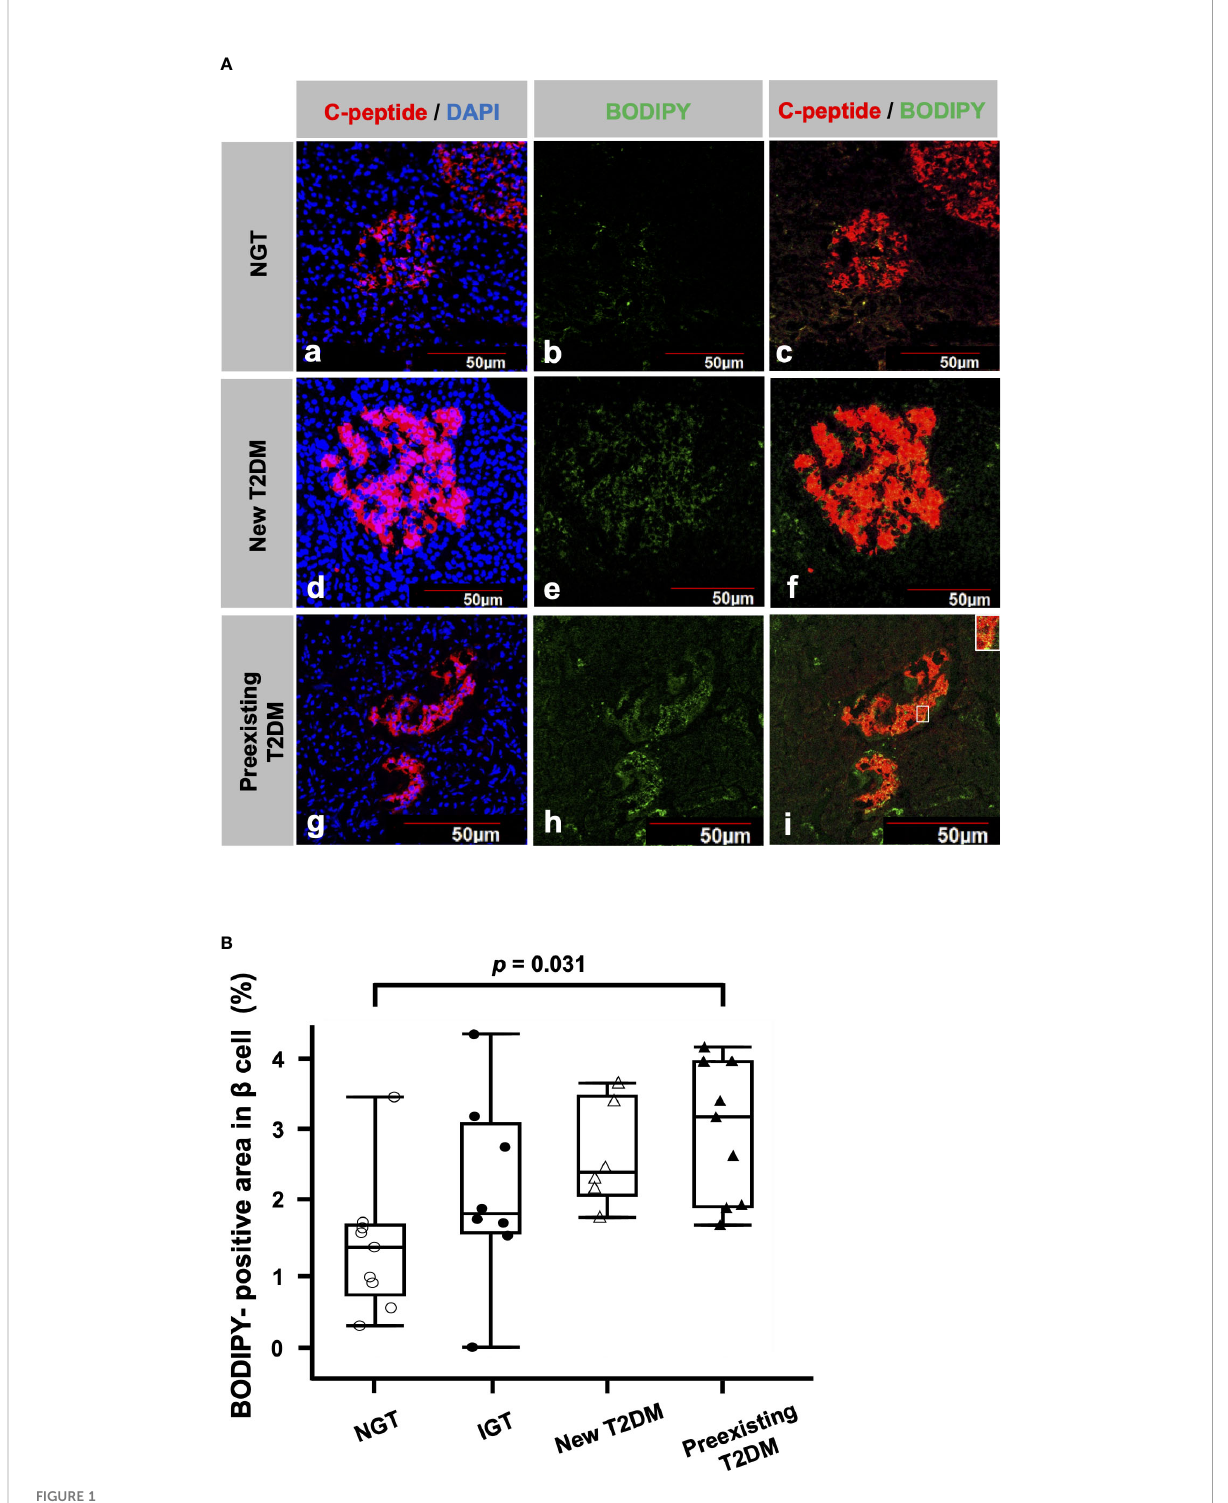
FIGURE 1 Lipid droplets (LDs) in b cells (A) Representative immuno fl uorescence staining for C-peptide (red), BODIPY (green) and DAPI (blue) from patients with NGT (a-c) , newly diagnosed T2DM (d-f) and preexisting T2DM (g-i) . Bars, 50 m m. (B) : Comparisons of BODIPY-positive areas in b cells among the NGT (n= 9), IGT (n= 8), newly diagnosed T2DM (n= 6) and preexisting T2DM groups (n=